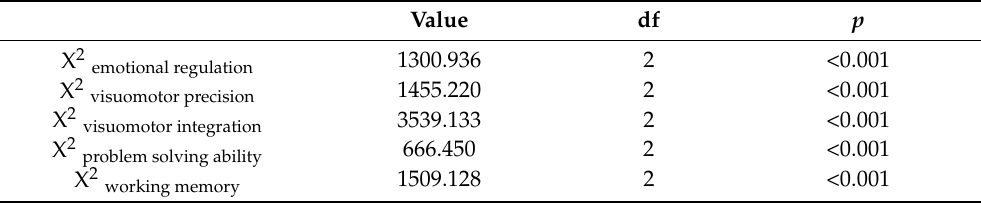
Table 2. Differences depending on emotional regulation, visuomotor precision, visuospatial integra- tion, problem-solving ability and working memory in terms of school results of pupils with ADHD compared to children without this